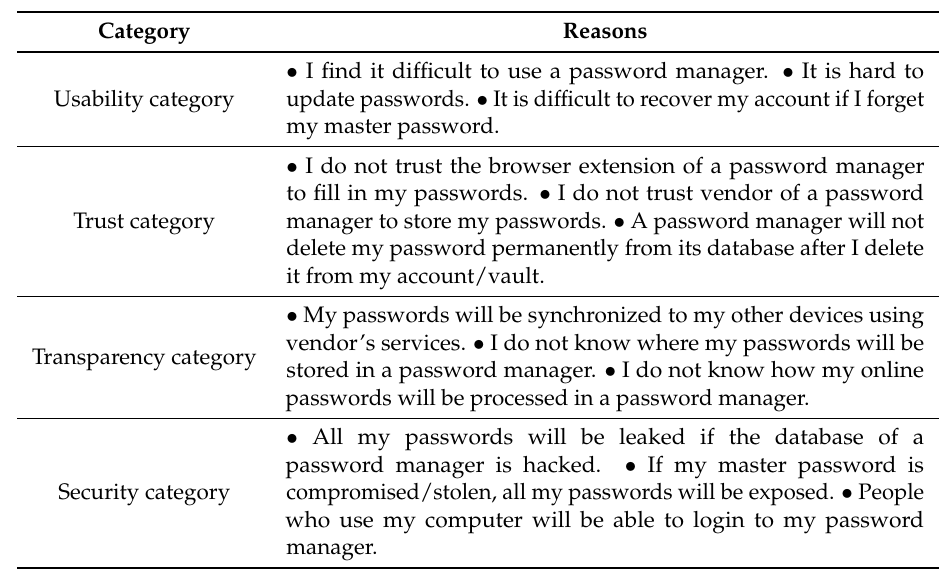
Table 21. Every three reasons from Table 20 were grouped in a category. McNemar test was used to see if there was any significant difference between these